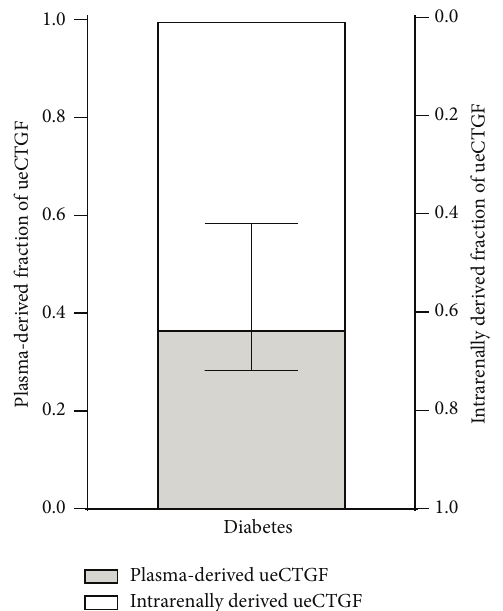
Figure 2: In diabetic mice, plasma-derived endogenous CTGF (eCTGF) accounts for 37% of urinary eCTGF (ueCTGF), while intrarenally derived CTGF accounts for 63% of ueCTGF (median with interquartile range).